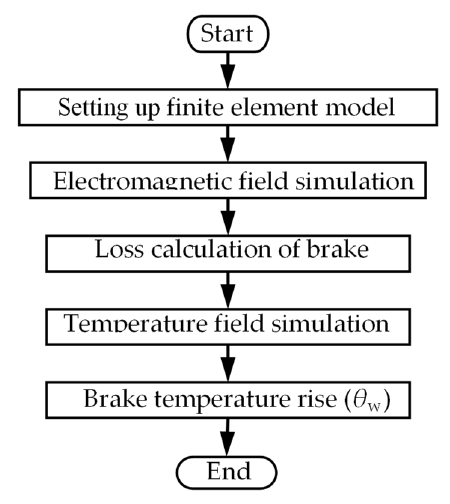
Figure 3. The one-way method flow chart.